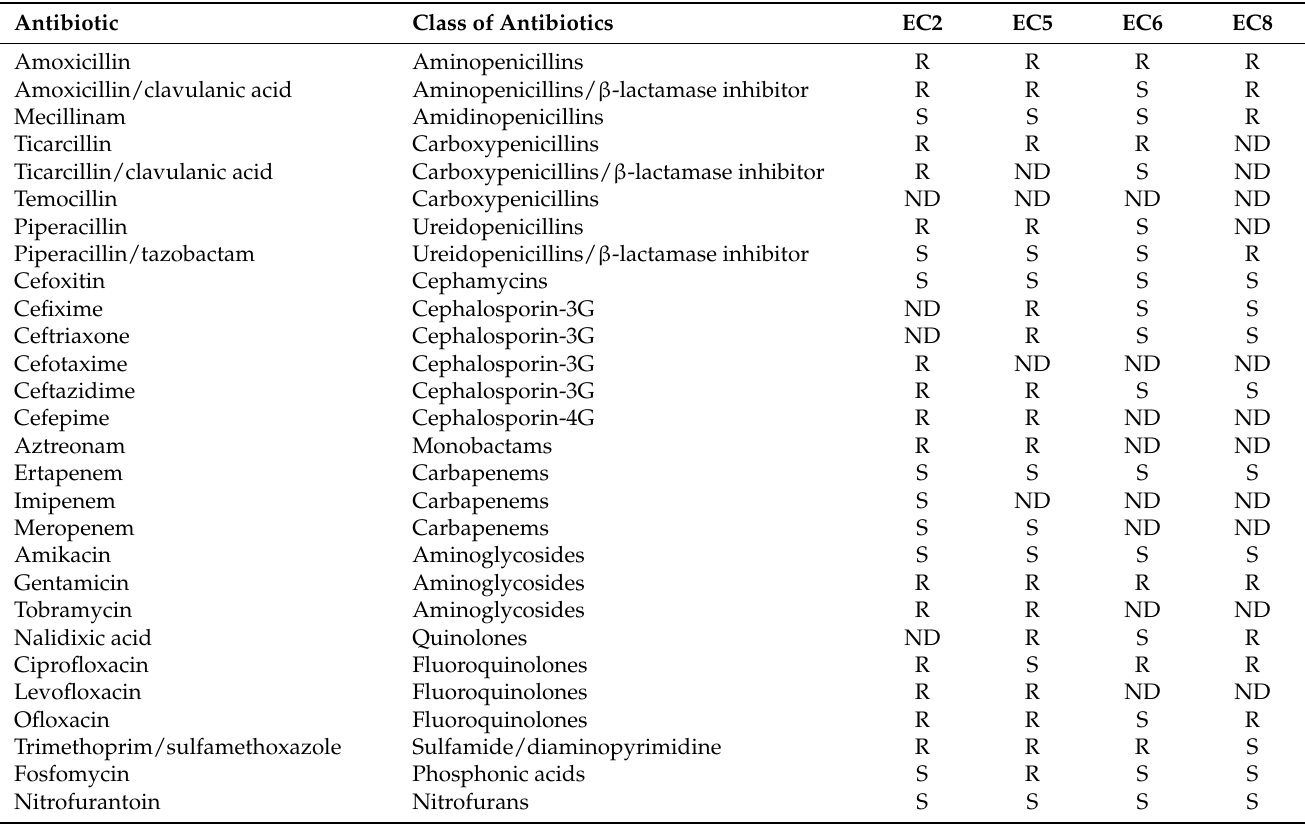
Table A2. Antibiograms of the four Escherichia coli multidrug resistant strains.